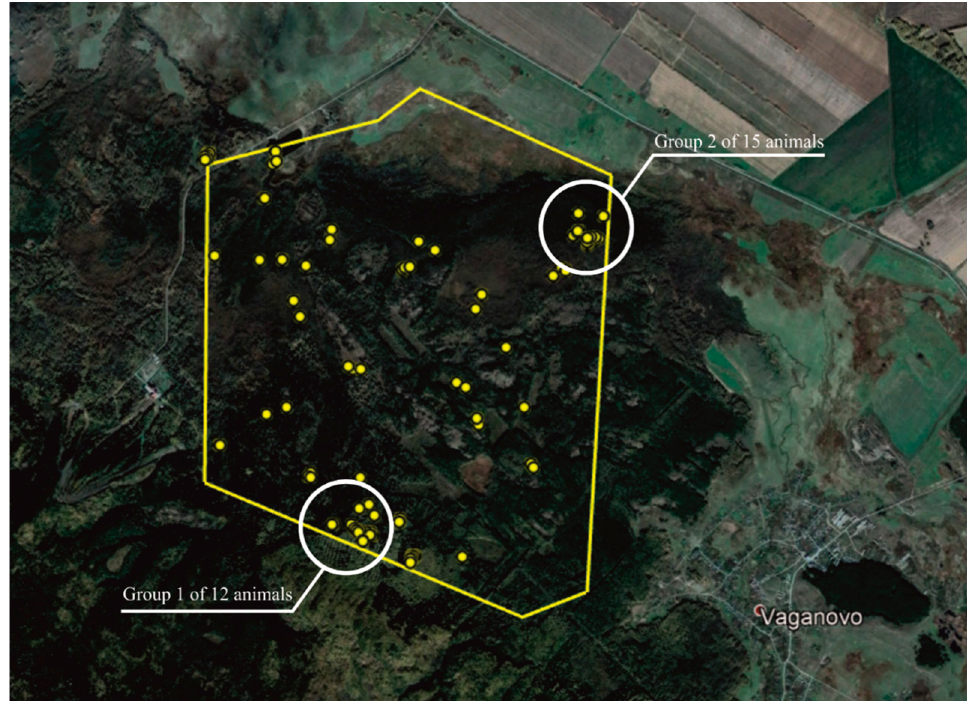
Figure 5. Map of the elk population in the area surveyed in 2020. Two animal clusters were identified outside the Tanay resort.